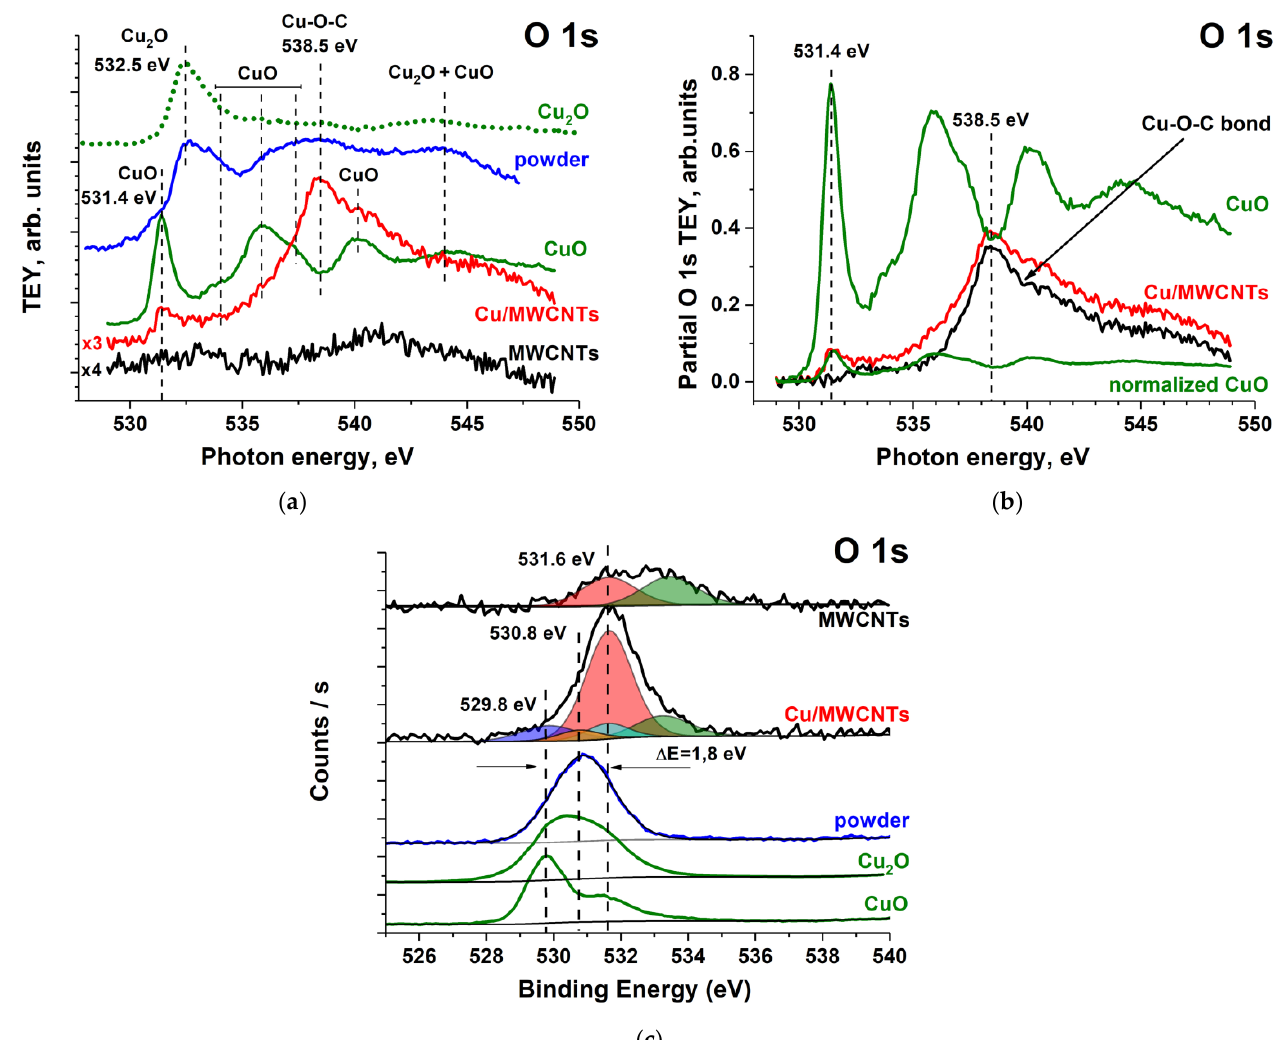
Figure 10. ( a ) The measured O 1s NEXAFS spectra of the initial nanotube, Cu/MWCNTs hybrid nanocomposite, powder and CuO, and Cu 2 O O 1s NEXAFS spectrum taken from [61]; ( b ) the TEY partial spectra in the O 1s NEXAFS region from Cu/MWCNTs hybrid nanocomposite, CuO oxide, CuO oxide normalized to the first peak (531.4) in the composite and Cu – O – C contribution is obtained as the difference between the nanocomposite and normalized CuO spectra; ( c ) The measured O 1s XPS spectra of the initial nanotube, Cu/MWCNTs hybrid nanocomposite and powder, and CuO and Cu 2 O O 1s XPS spectra taken from [57].